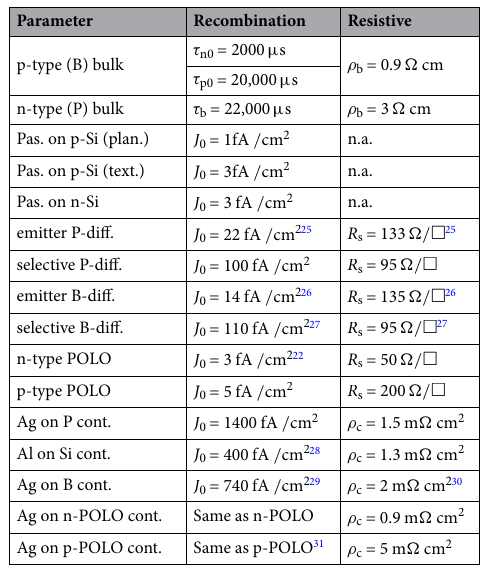
Table 1. Electronic input parameters for the device simulations. All parameters without a reference are ISFH internal